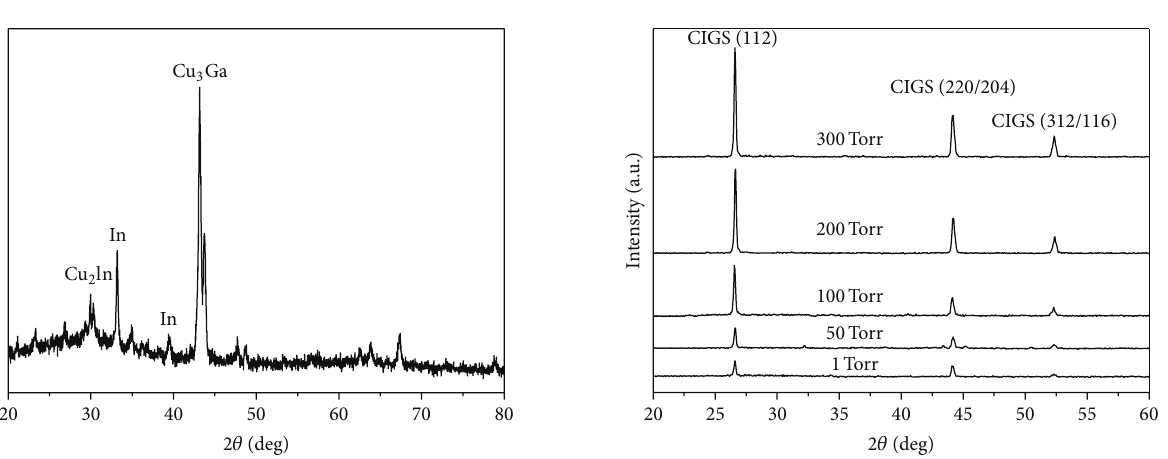
Figure 3: The XRD patterns of the In/Cu-Ga precursor produced using an In deposition time of 120min. JCPDS: Cu 2 In (00-026-